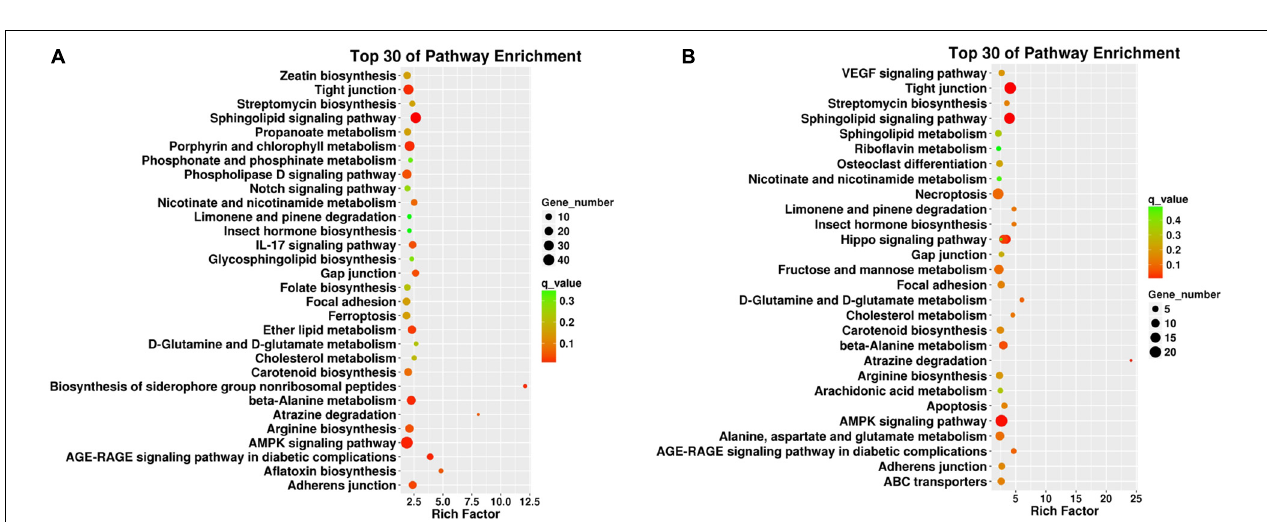
FIGURE 5 | Gene number distribution in different KEGG classification terms. Top KEGG terms in (A) roots and (B) leaves. The x-axis indicates the number of genes enriched in such KEGG term, and the colors of the bar indicate different KEGG classes including cellular processes and environmental information processing.